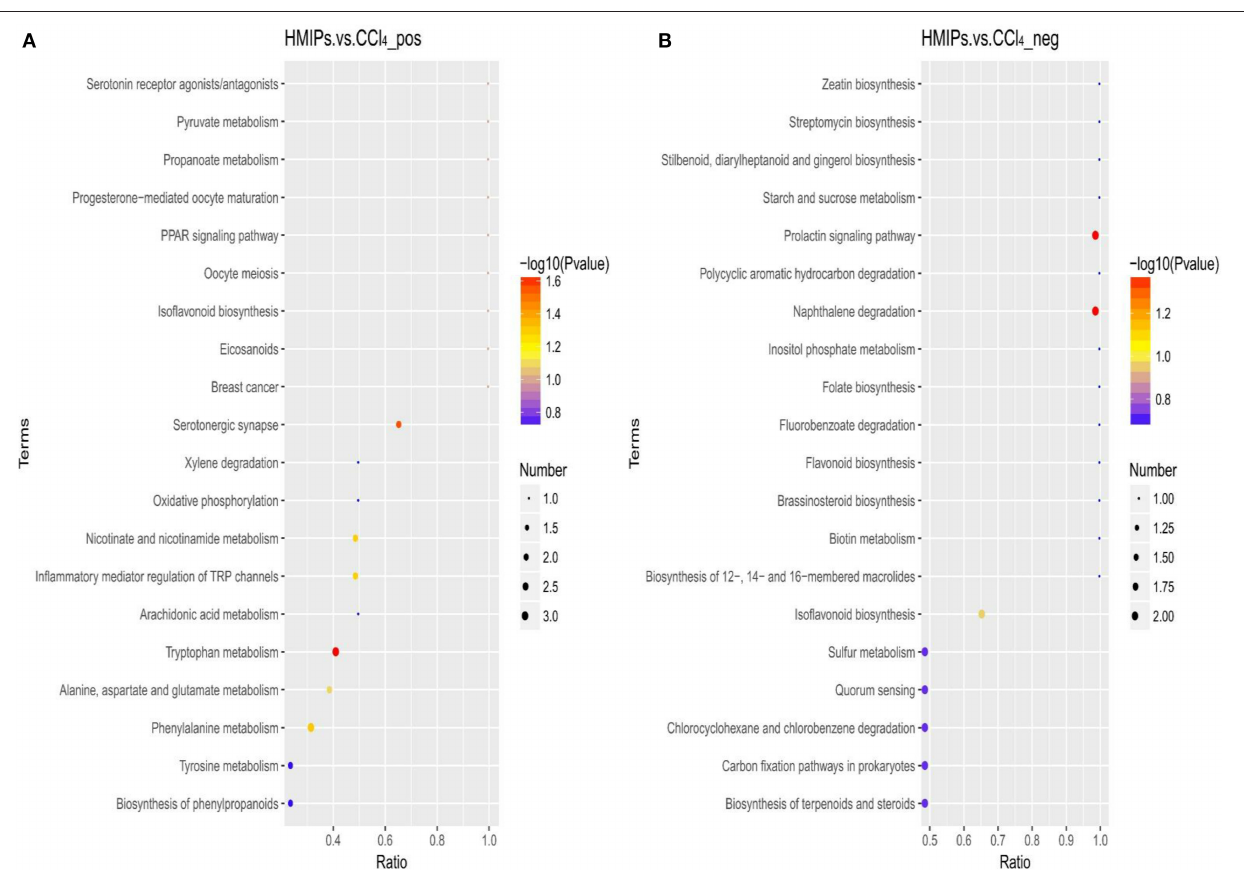
FIGURE 12 | Bubble plots for identification of the most relevant metabolic pathways between the HMIP and CCl 4 groups under the positive (A) and negative (B) ion models.